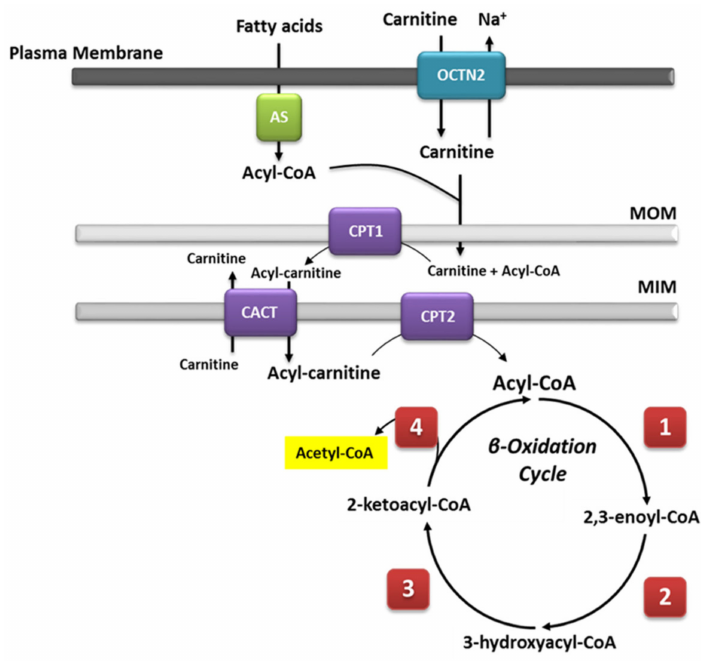
Figure 1. Schematic representation of the mitochondrial fatty acid β -oxidation. Long-chain fatty acids need to be transported into the mitochondria by an active transport system. Because fatty acids in the cytoplasm are activated as acyl-CoA esters, they must be bound to carnitine for transport across the mitochondrial membranes. In contrast, medium- and short-chain fatty acids do not need an active transport system and can easily undergo β -oxidation. This pathway consists of four cyclic steps. Each step shortens the acyl-CoA by two carbons. The electrons generated by each oxidative reaction are transferred to FAD or NAD+ and are forwarded to ubiquinone or the respiratory chain, respectively. (1) Acyl-CoA dehydrogenase (very long-, long-, medium-, and short-chain acyl- CoA dehydrogenase, i.e., VLCAD, long-chain acetyl-CoA dehydrogenase (LCAD), medium-chain acyl-CoA dehydrogenase (MCAD), and SCAD, respectively).; (2) 2,3-Enoyl-CoA hydratase (LCEH and SCEH). (3) 3-Hydroxyacyl-CoA dehydrogenases (LCHAD and SCHAD). (4) β -Ketoacyl-CoA thiolase (LCKAT, MCKAT, and SCKAT). MIM, mitochondrial inner membrane; MOM, mitochondrial outer